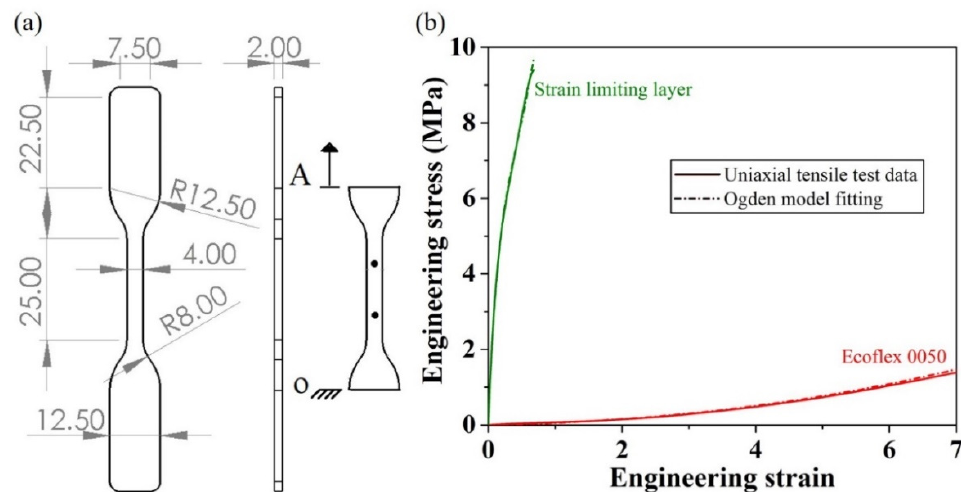
Figure A1. Uniaxial tensile tests: ( a ) Schematics of a sample used for tensile test. The values are in mm. The inset shows the gauge points used to measure the axial strain by using a digital-image-correlation (DIC) method. The horizontal lines at “O” and “A” in the shoulder region indicate where the specimens were gripped at the shoulders of the dog-bone specimens. ( b ) Uniaxial tensile engineering stress-strain graph of Ecoflex 0050 and strain-limiting layer as well as the Ogden model fitted to their respective tensile test data.